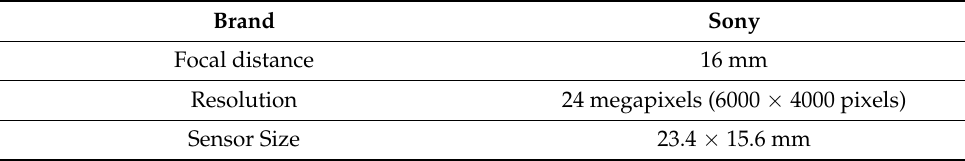
Figure 3. Flight plans with different orientations of flight lines: ( a ) 0°, ( b ) 45°, and ( c ) 120° and image overlap of 75%, realized with UgCS software. Table 3. Characteristics of the digital camera used for flight plans.